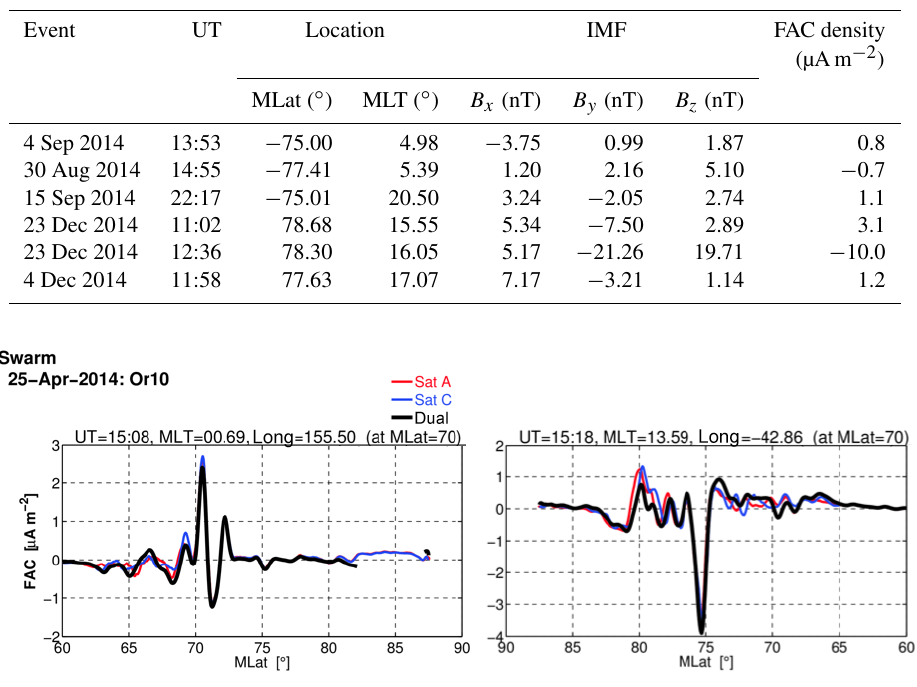
Figure 1. Example of field-aligned current recording for a high-latitude pass from post-midnight to afternoon. Generally, single- and dual- satellite FACs agree very well in the auroral region, and there is low FAC activity in the polar cap.